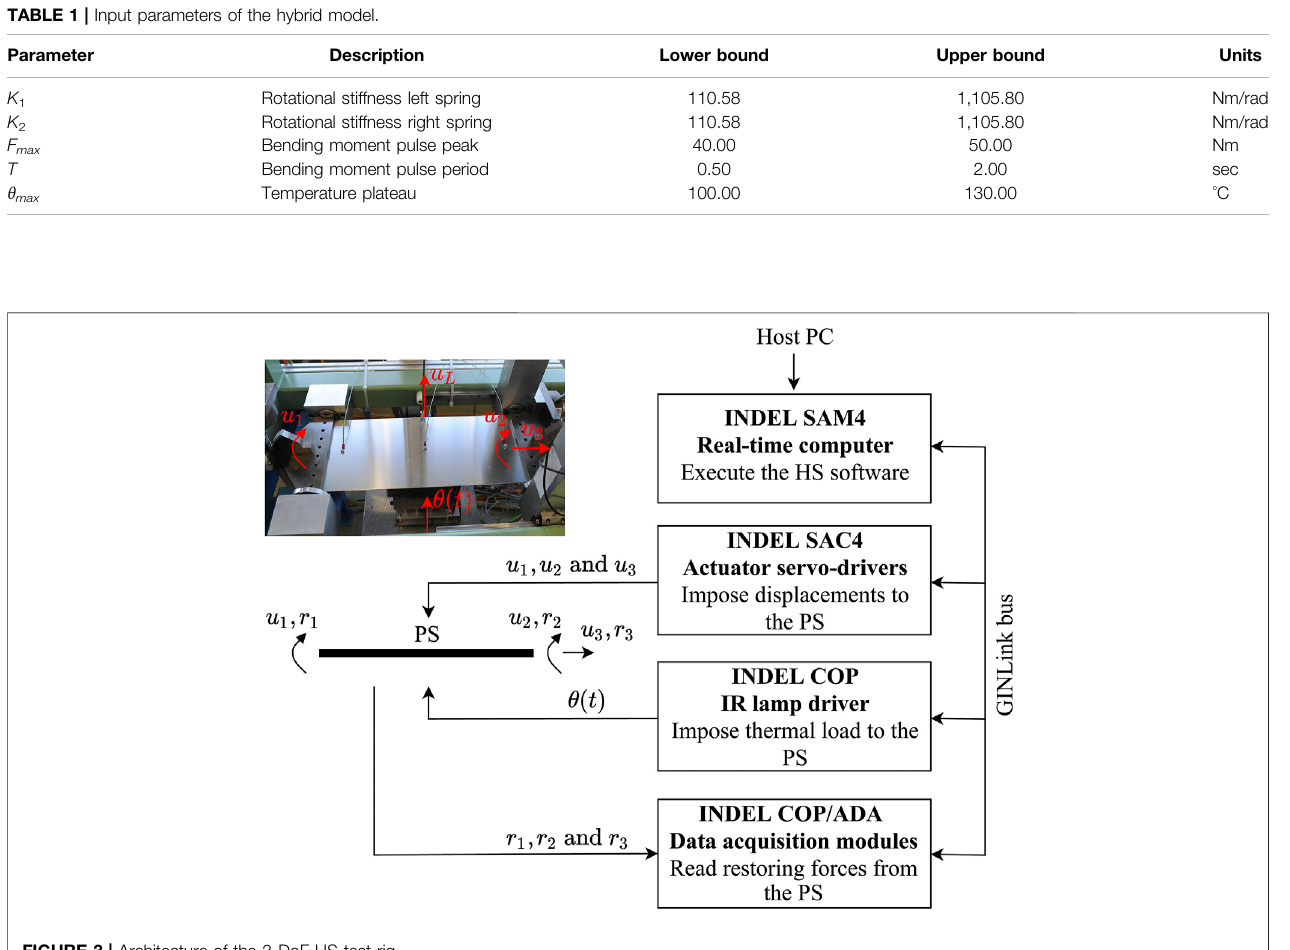
TABLE 1 | Input parameters of the hybrid model.